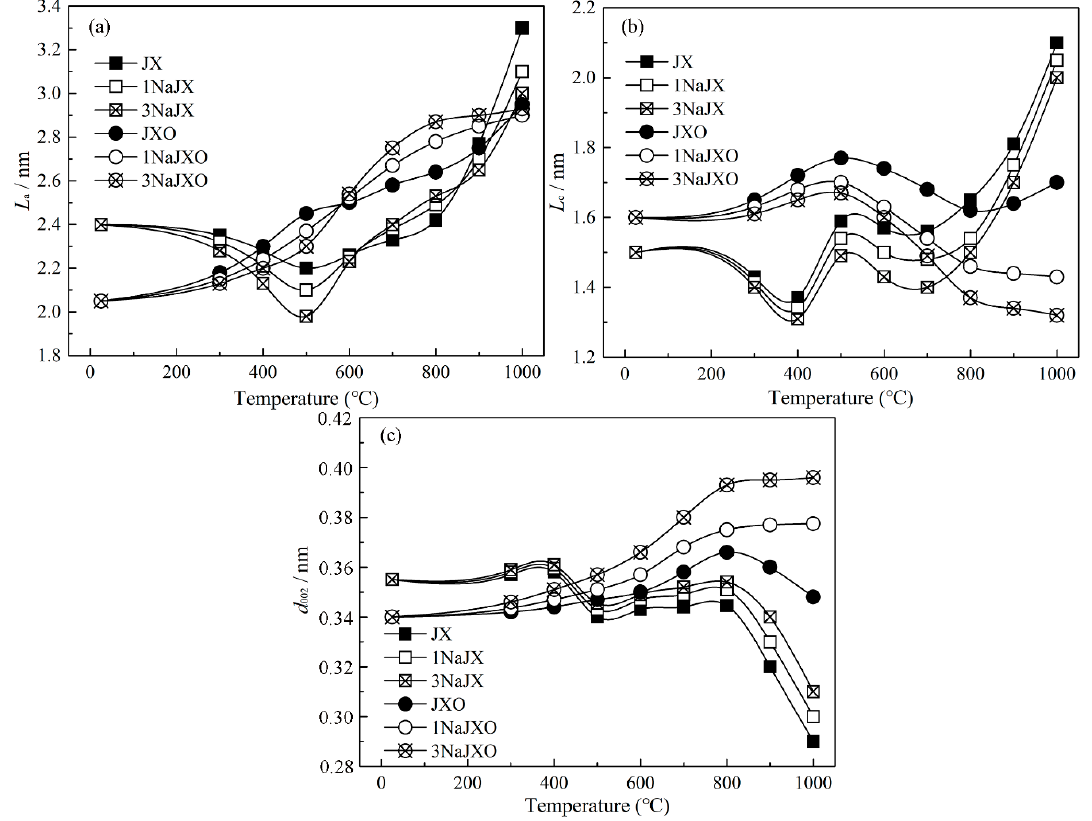
Figure 3. XRD data from chars at pyrolysis ( a ) L a ; ( b ) L c ; ( c ) d 002 .